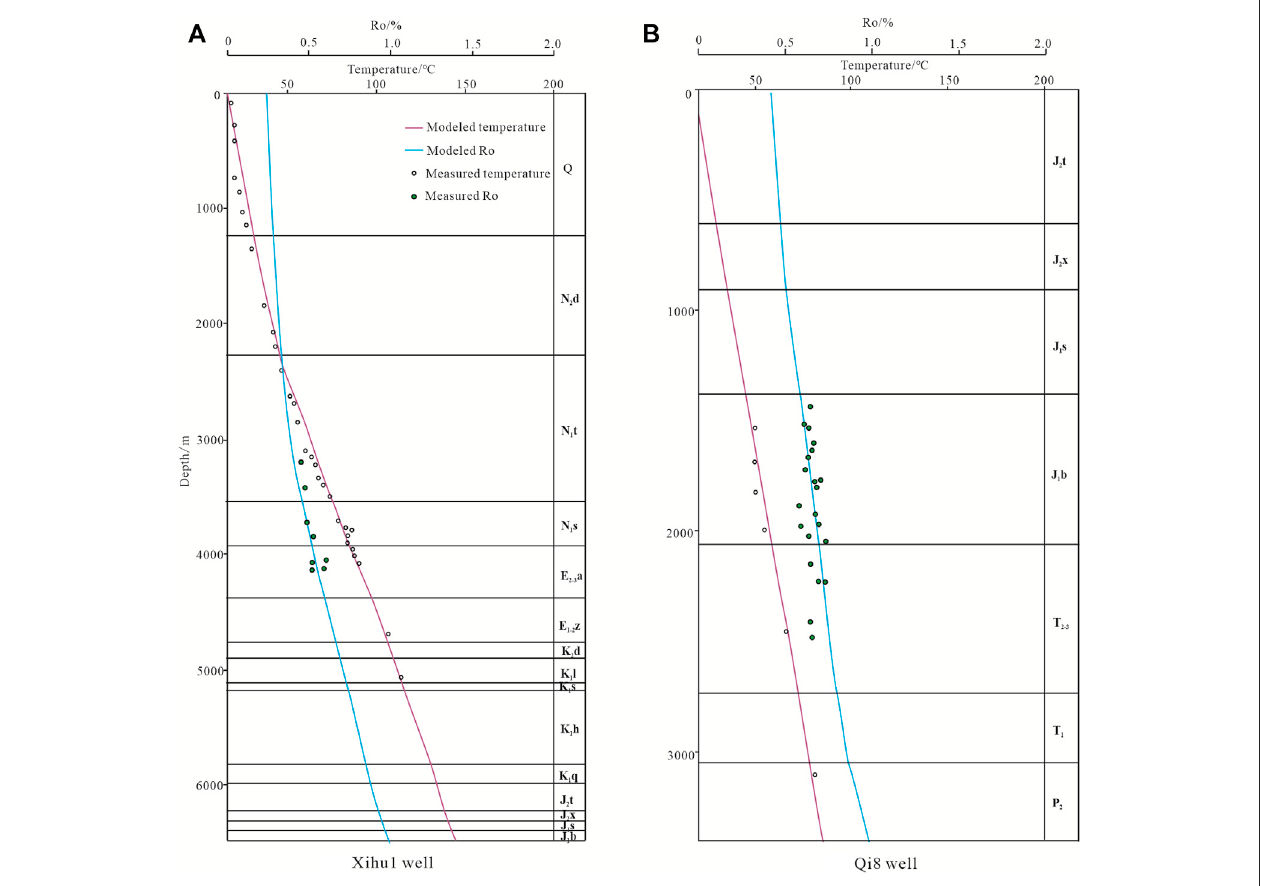
FIGURE 8 | Consistency between modeled and measured temperature and Ro in Xihu1 and Qi8 well. (A) Consistency between modeled and measured temperature and Ro data in Xihu1 well. (B) Consistency between modeled and measured temperature and Ro data in Qi8 well.